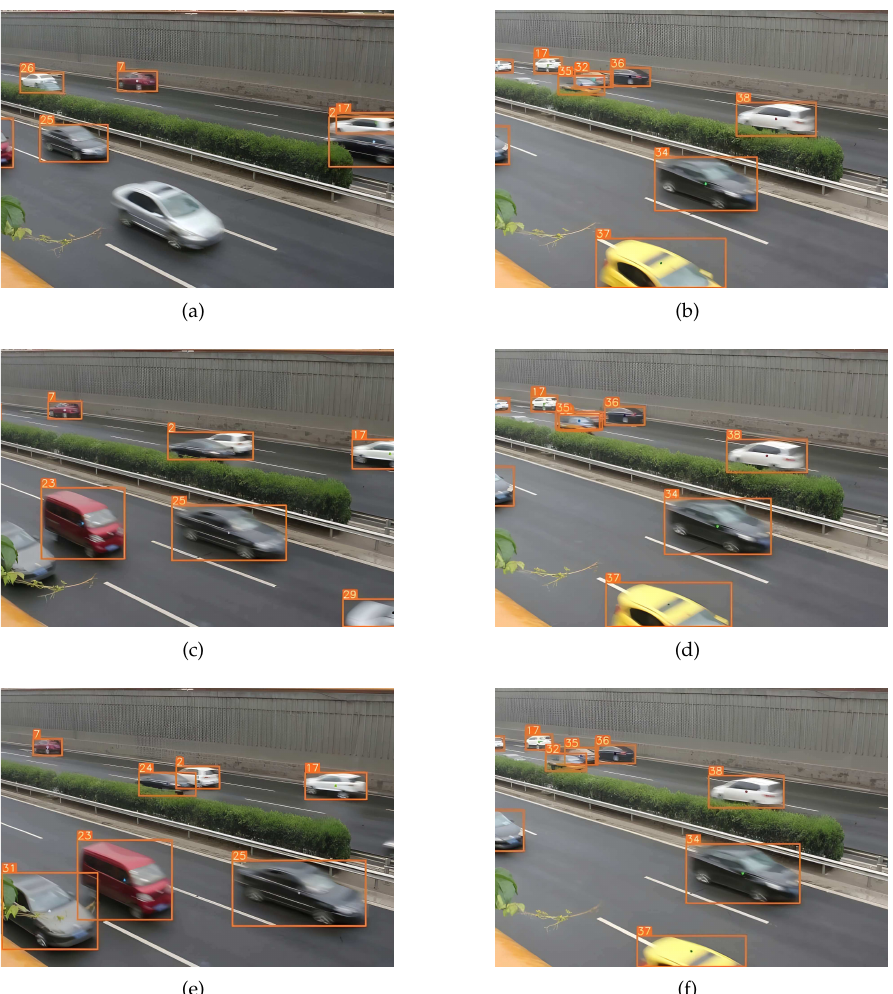
Figure 10. Data association failure. ( a ) frame 115; ( b ) frame 187; ( c ) frame 132; ( d ) frame 188; ( e ) frame 137; ( f ) frame 190.